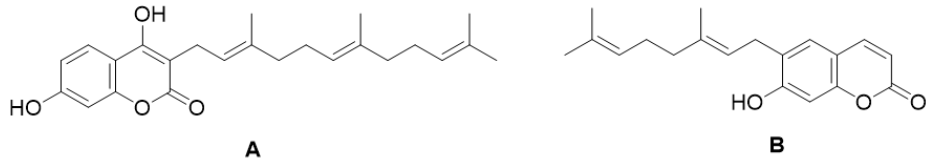
Figure 12. Chemical structures of ammoresinol ( A ) and ostruthin ( B ).